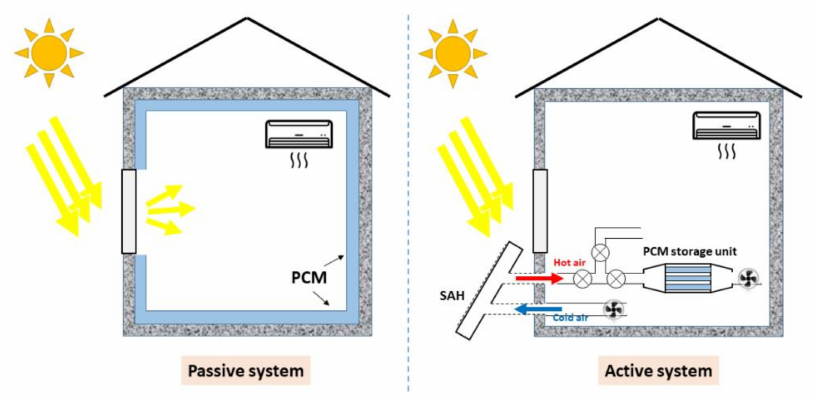
Figure 2. Passive and active systems integrated in tested prototypes